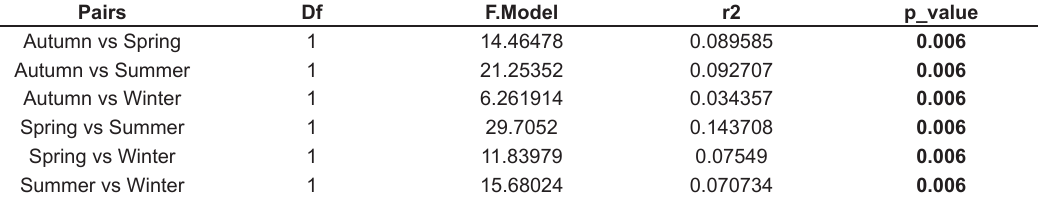
Table 2. Results of the pair-by-pair test of the permutational multivariate analysis of variance (PERMANOVA) applied to the diet data of Serrapinnus notomelas in the autumn, spring, summer, and winter